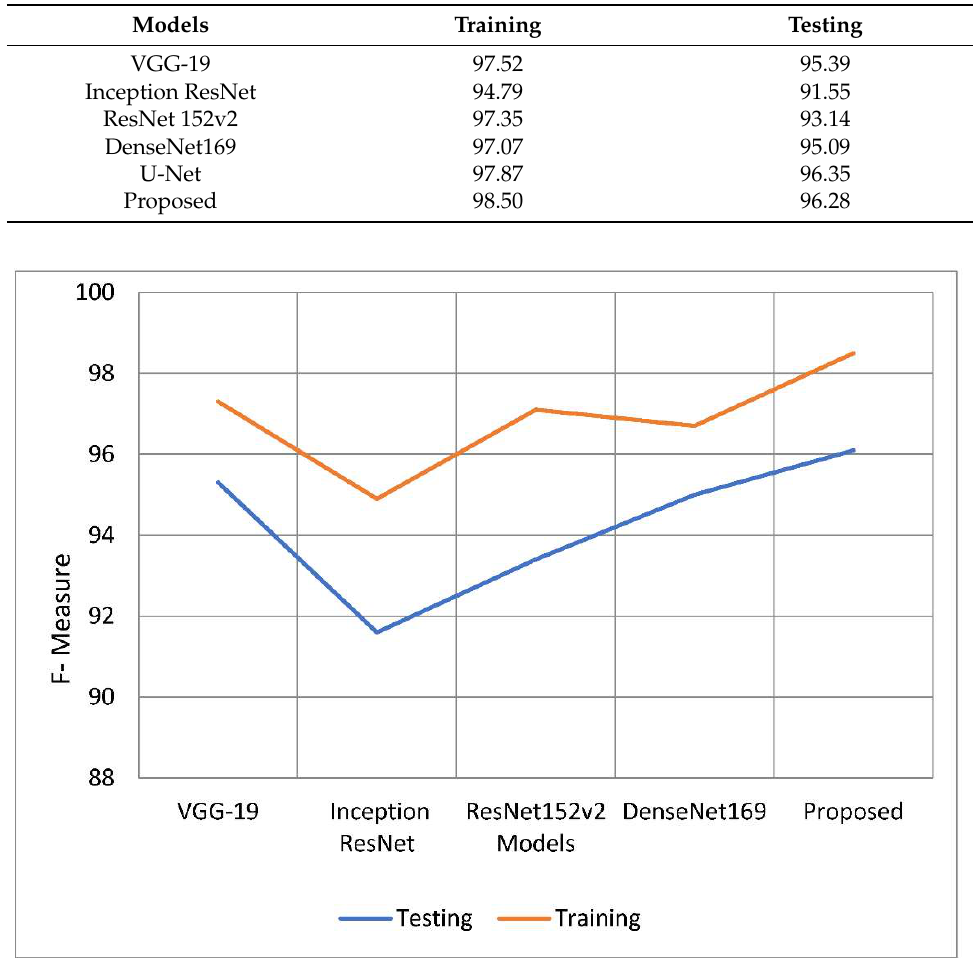
Figure 12. F-measure of the proposed model with traditional models.